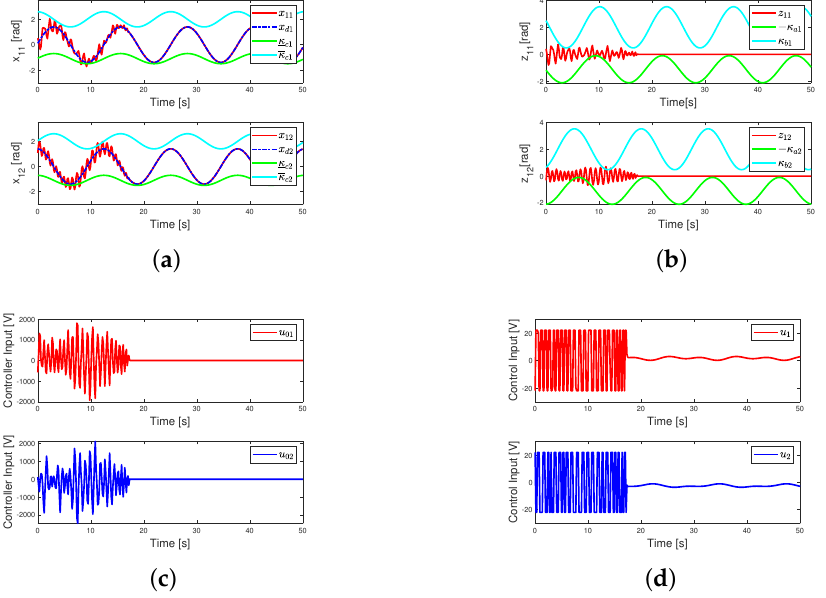
Figure 3. The control performance. ( a ) tracking performance of x 1 ; ( b ) tracking error: z 1 ; ( c )